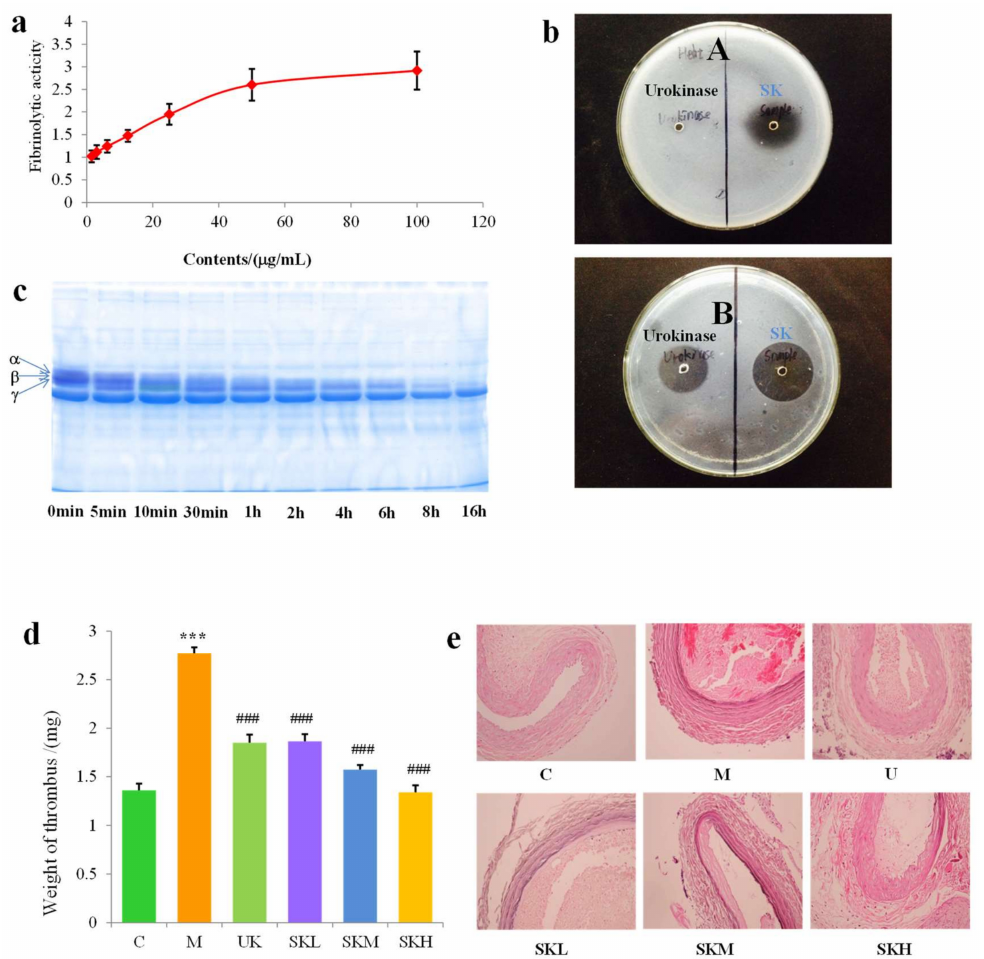
Figure 4. Fibrinolytic activity, fibrinogenolytic activity, and effects on FeCl 3 -induced common carotid arterial thrombosis rat of SK. ( a ) The fibrinolytic activities of SK with different concentration. ( b ) The fibrinolytic activities of urokinase and SK in both plasminogen-free (A) and plasminogen-rich (B) fibrin plates. ( c ) Structure of fibrinogen after effect of SK for different time, and α , β and γ were defined as three polypeptide chanins α , β and γ . ( d ) Effects of SK on the common carotid artrial thrombus weight in rats. *** p < 0.001 vs. Sham-operated group; ### p < 0.001 vs. Model group. ( e ) Effects of SK on histomorphology of common carotid arterial thrombus in rats (HE, ×